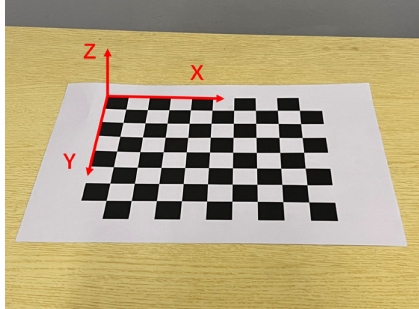
Figure 2. Calibration board.